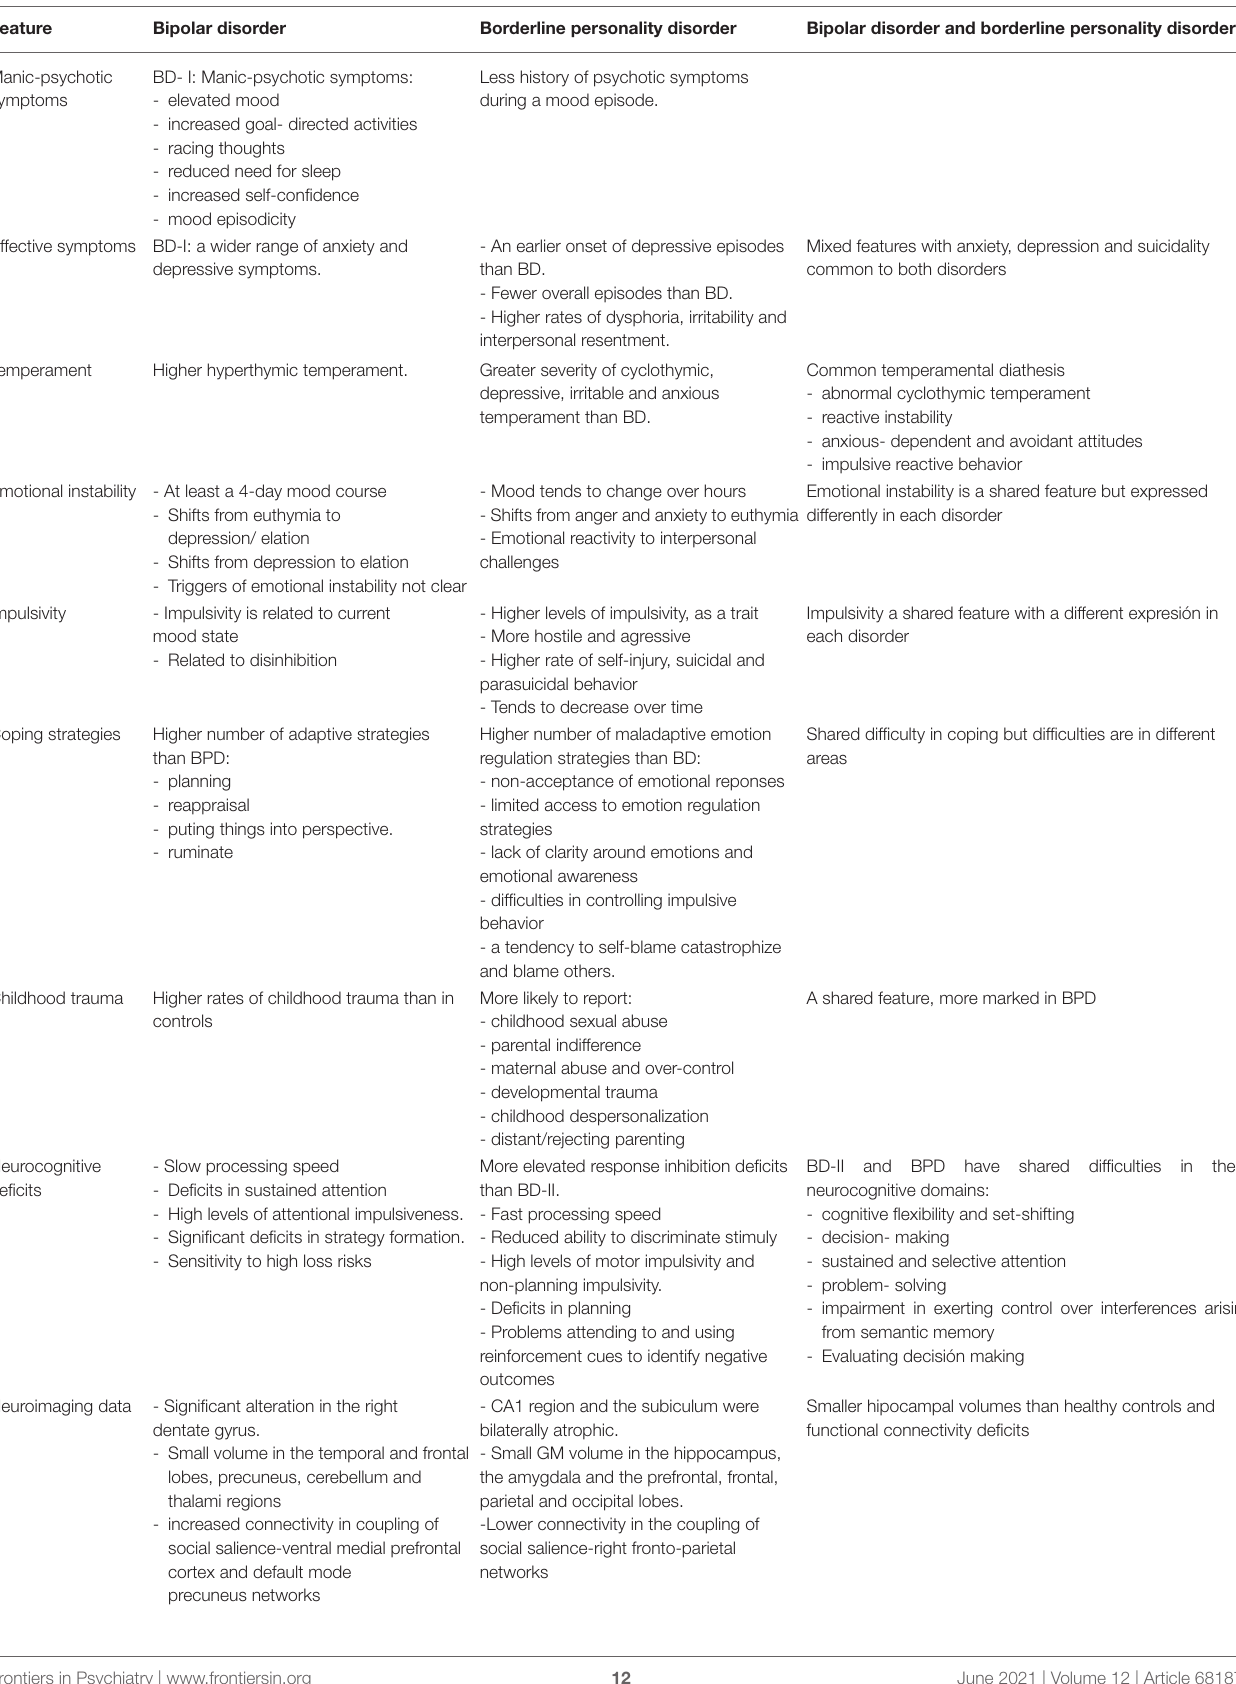
TABLE 4 | Specific and shared features of bipolar disorder and borderline personality disorder.